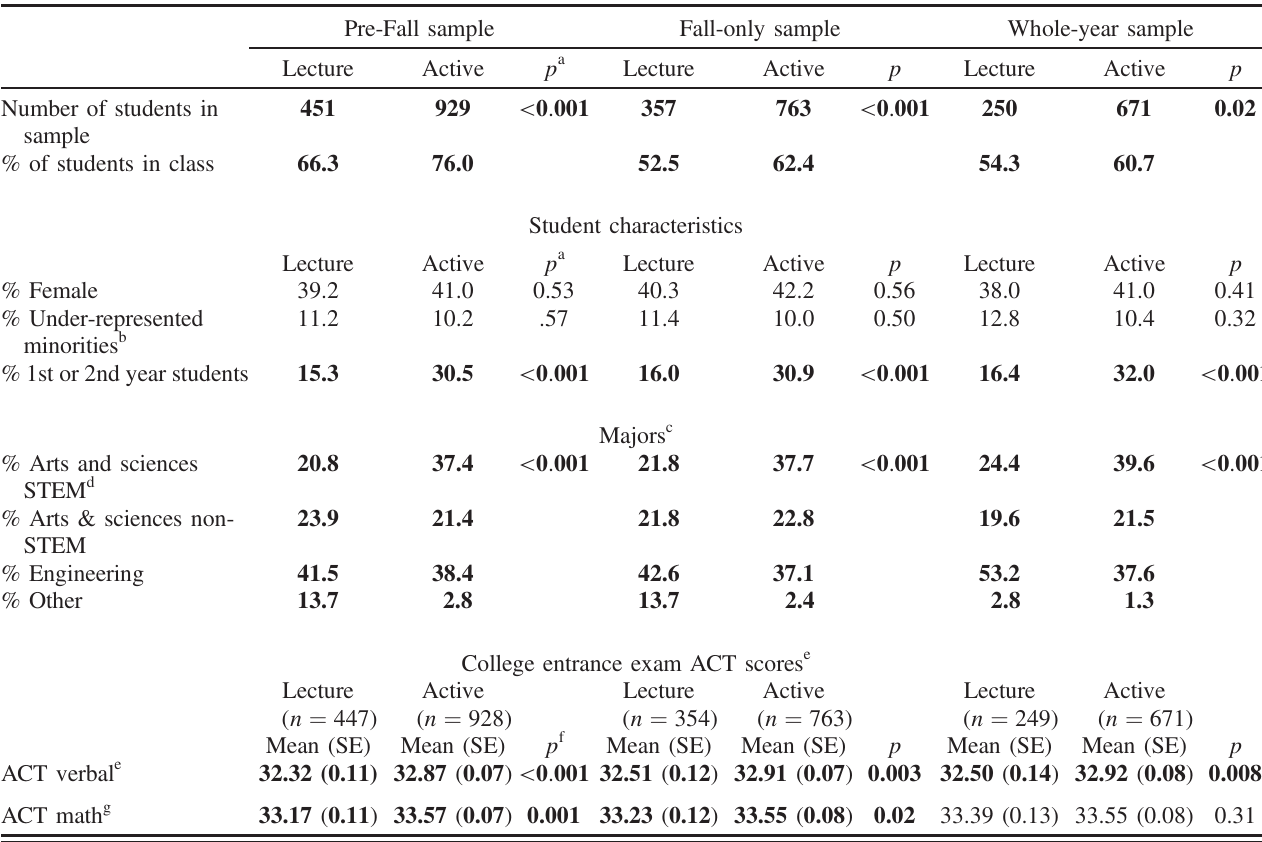
TABLE I. Demographics for students taking the CLASS survey. Bold cells indicate a significant difference between traditional-lecture physics and Active Physics. SE indicates Standard